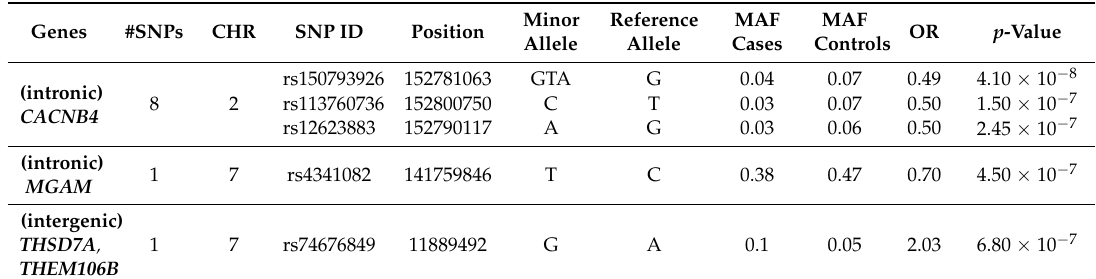
Table 1. Top genome-wide association hits at p < 1.0 × 10 − 6